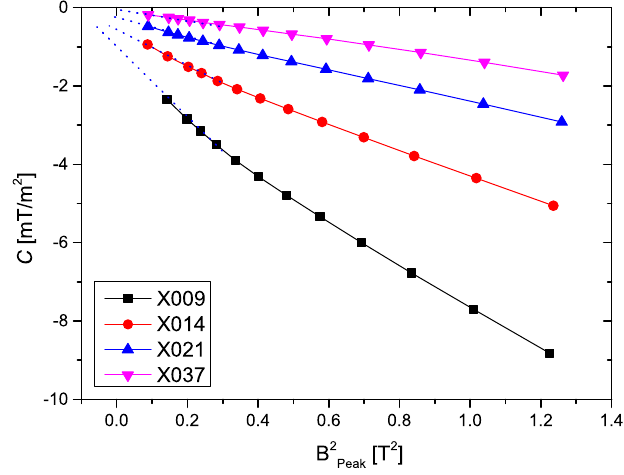
FIG. 2. Coefficient C [see Eq. (3)] vs square of the peak field to demonstrate the variation of girder deformation. The black data points result from initial measurements on a device which was rejected and reconstructed.